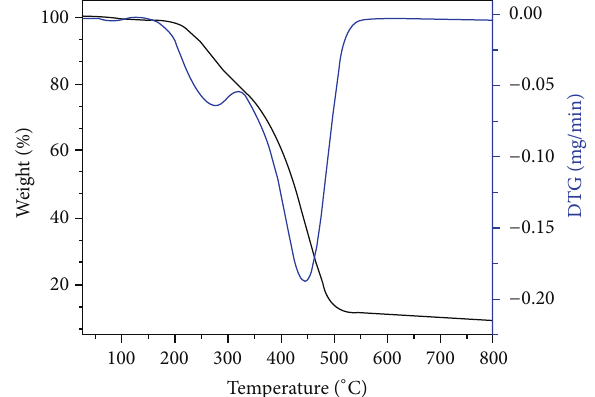
Figure 11: TGA/DTG thermogram of PUEAF25.